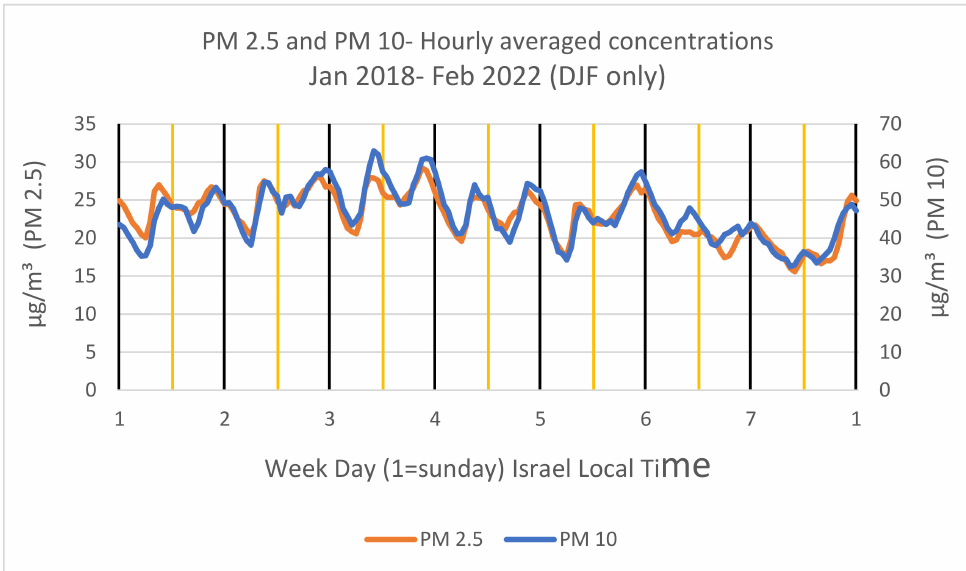
Figure 2. Hourly averaged mass loading of PM2.5 (orange, left axis) and PM10 (blue, right axis) particles based on 6 stations within the study area for the period 2018–2022, DJF months only. Integer numbers mark midnight of the day (1 = Sunday) and the solid vertical lines mark the midnight hour. A daily cycle, reflecting traffic loads within the Tel-Aviv Metropolitan Area, is evident with a minimum on the Sabbath